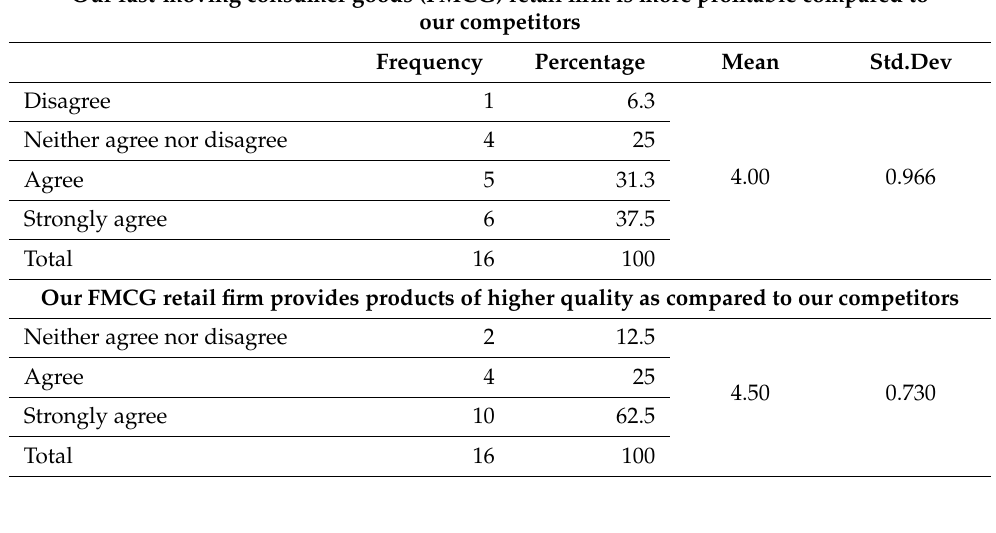
Table 3. RL firms’ competitiveness based on